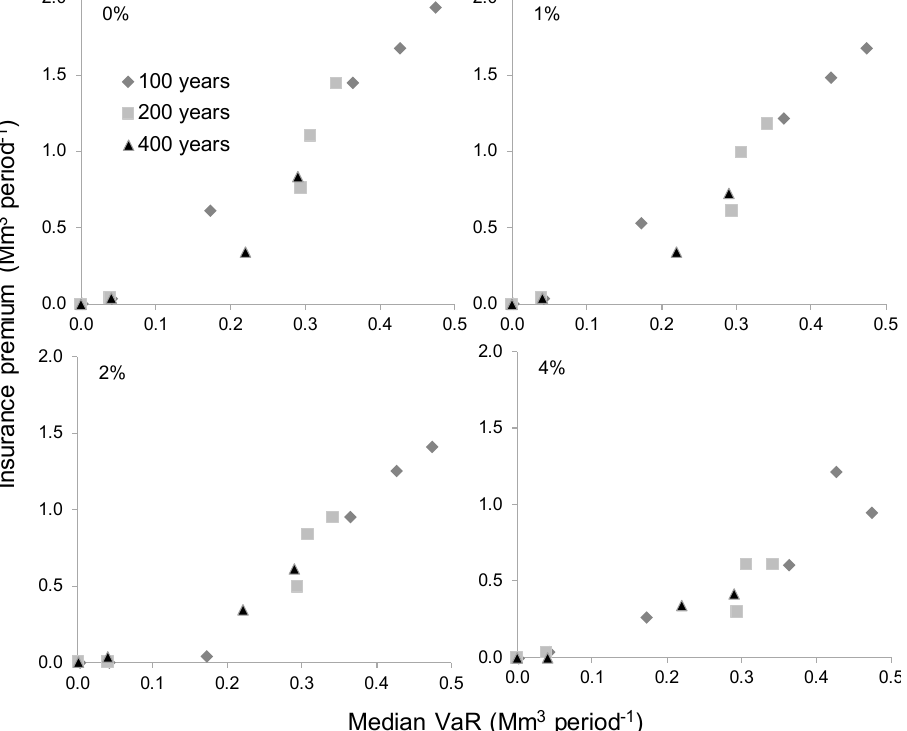
Figure 6. Distribution of the planned timber harvest into: a part that is not entirely feasible (planning optimism, in white, see Figure 4), a part that should be used to build a buffer stock of timber ( dark gray ) (with a timber harvest reduction—THR, which should not be harvested, or with an insurance premium, which should be harvested and set apart, with an interest rate between 0% and 4%) (protection strategy), and a part available for harvest ( light grey ), considering three possible fire cycles.